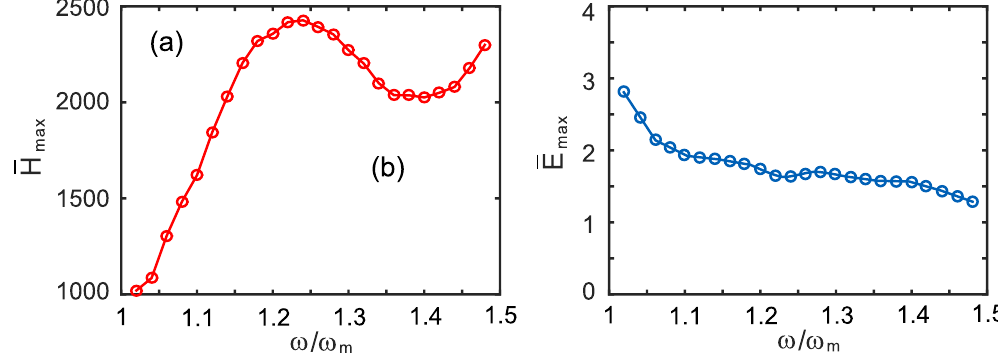
, ( b ) E . The other max max